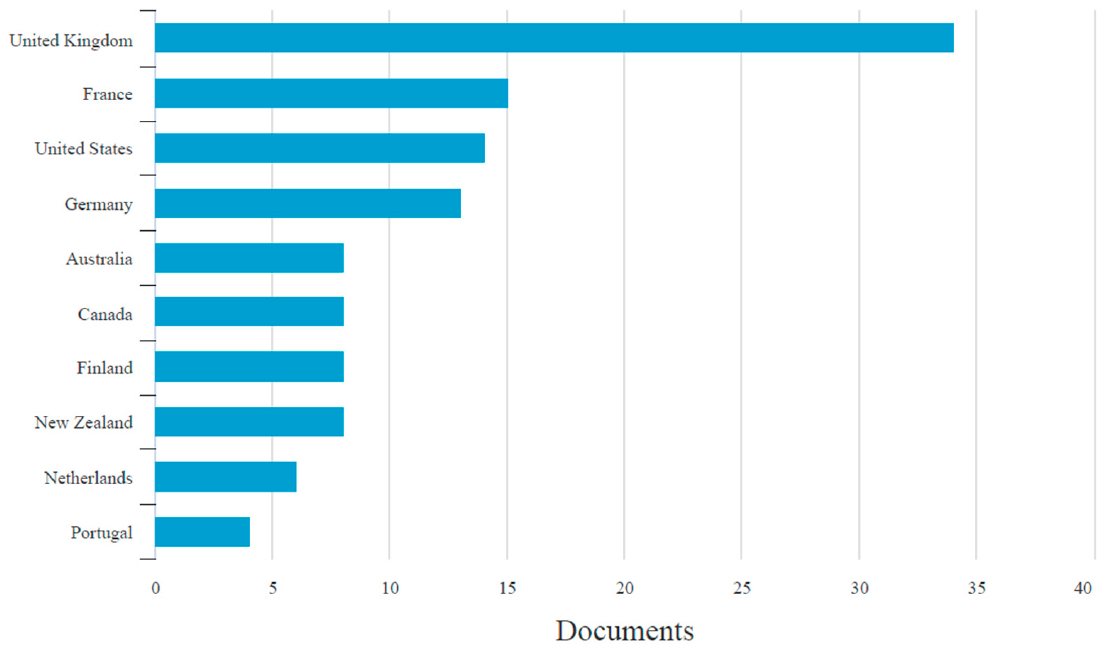
Figure 11. Self-initiated expatriation documents by country or territory. Source: Data obtained from Scopus (August 2022).